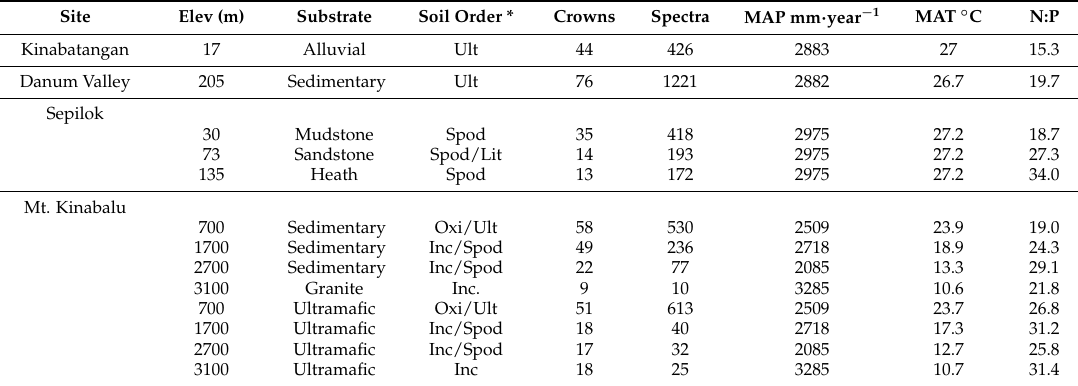
* Abbreviations of soil orders are: Spod = spodosol, Lit = lithosol, Oxi = Oxisol, Ult = Ultisol, Inc = Inceptisol. LiDAR data are essential to precisely ortho-geolocate the VSWIR data in order to mask canopy gaps, account for intra- and inter-canopy shadowing, and to identify regions of short or absent canopies that contaminate the spectral signal [26]. To achieve this, the laser ranges were combined with the embedded high resolution Global Positioning System-Inertial Measurement Unit (GPS-IMU) data to determine the 3D locations of laser returns, producing a ‘cloud’ of LiDAR point data. These points were used to interpolate a raster digital terrain model (DTM) for the ground surface of each landscape. This was achieved using a pair of tools within the LAStools software suite (Rapidlasso GmbH, Gilching, Germany). Ground returns were detected using the program lasground with a step size of 10 m. Interpolation of ground points to a raster DTM was performed using the program las2dem. The digital surface model (DSM) was created with las2dem using interpolations of all first-return points. Measurement of the vertical difference between the DTM and DSM yielded a digital canopy model (DCM) of vegetation height above